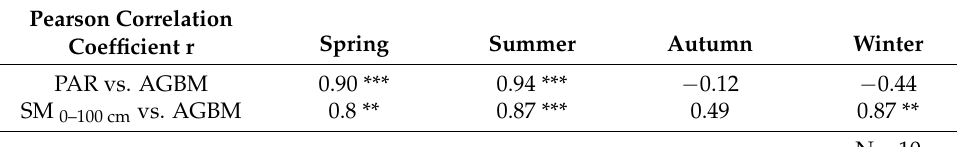
Table 5. Pearson correlation coefficient for correlations between PAR ( µ mol m − 1 s − 1 ) and AGBM (g DW m − 2 ) and SM 0–1000 mm (Vol%) and AG BM (g DW m − 2 ) in spring, summer, autumn, winter.